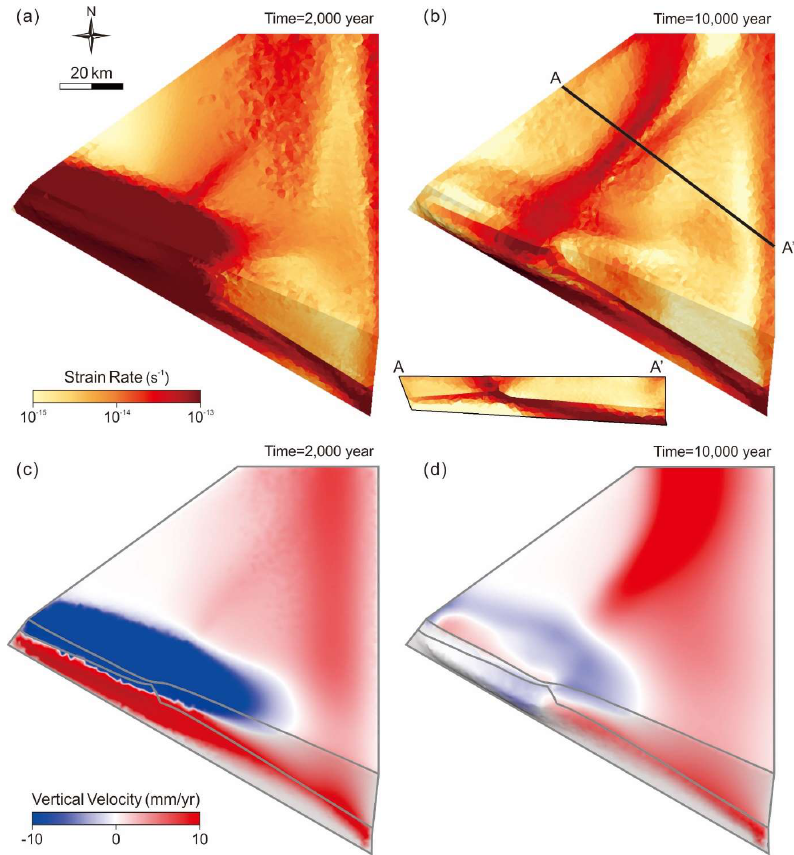
Figure 5. ( a ) The strain rate field at 2 kyr. ( b ) The strain rate field at 10 kyr. The strain rate field shows a similar pattern from 10 kyr to 40 kyr (Figure 4). The strain rate field reaches a quasi-stable state. ( c ) The vertical velocity field at 2 kyr. The area around the open boundary experienced strong subsidence. ( d ) The vertical velocity field at 10 kyr.